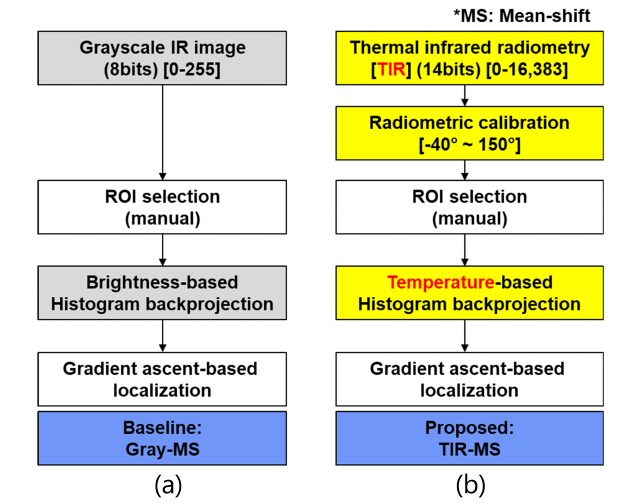
Figure 2. Flow chart of thermal infrared (TIR)-mean-shift (MS): ( a ) brightness-based MS, ( b ) temperature-based